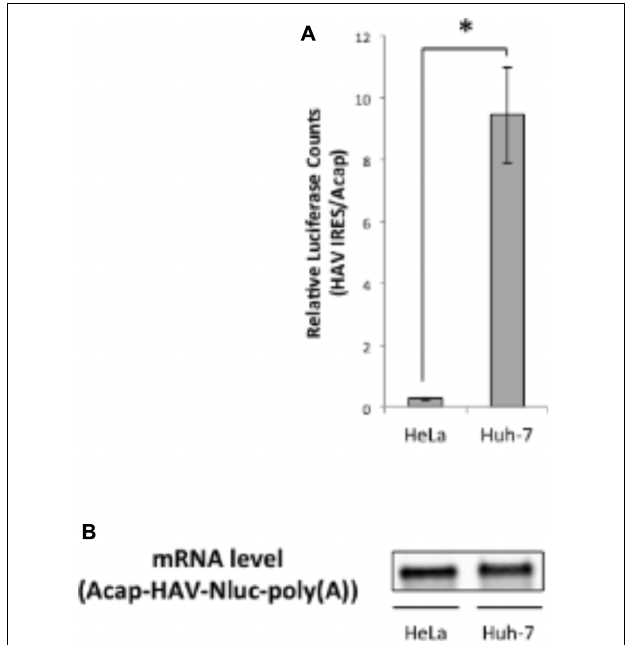
FIGURE 2 | Translation driven from HAV IRES in Huh-7 in vitro translation system is more efficient than in HeLa. (A) HeLa or Huh-7 translation extracts were mixed with Acap-HAV-IRES-Nluc-poly(A) or Acap-Nluc-poly(A) reporter mRNAs. HAV IRES-mediated translation was normalized by Acap-Nluc-poly(A) mRNA translation. The mean values ± SD from three independent experiments are shown. The asterisk indicates a statistically significant difference ( p < 0.05). (B) Physical stabilities of the Acap-HAV-IRES-Nluc-poly(A) mRNA at the end of the incubation were analyzed by Northern